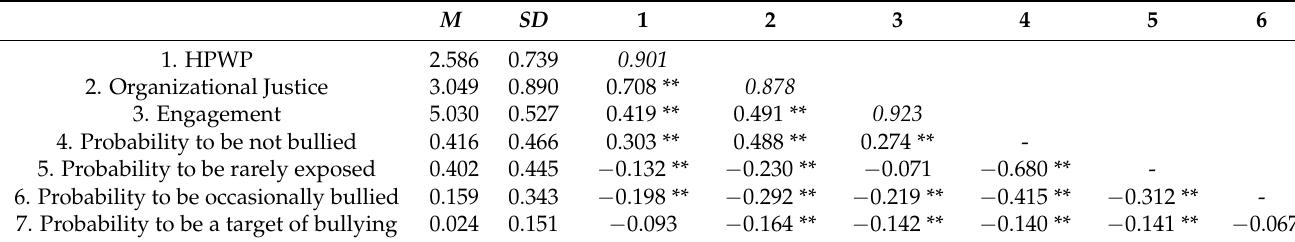
Table 2. Means, SD, and (auto)correlations of the studied concepts.